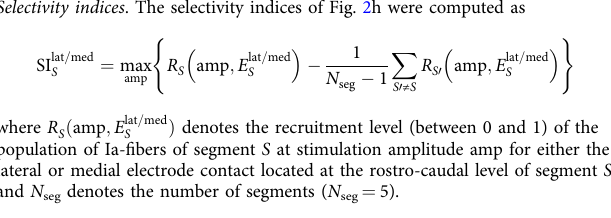
Figure 6. Same as above but populations of N = 100 motoneurons were simulated for each muscle, and the sizes of the Ia- fi ber populations were muscle- speci fi c (see Supplementary Table 1).